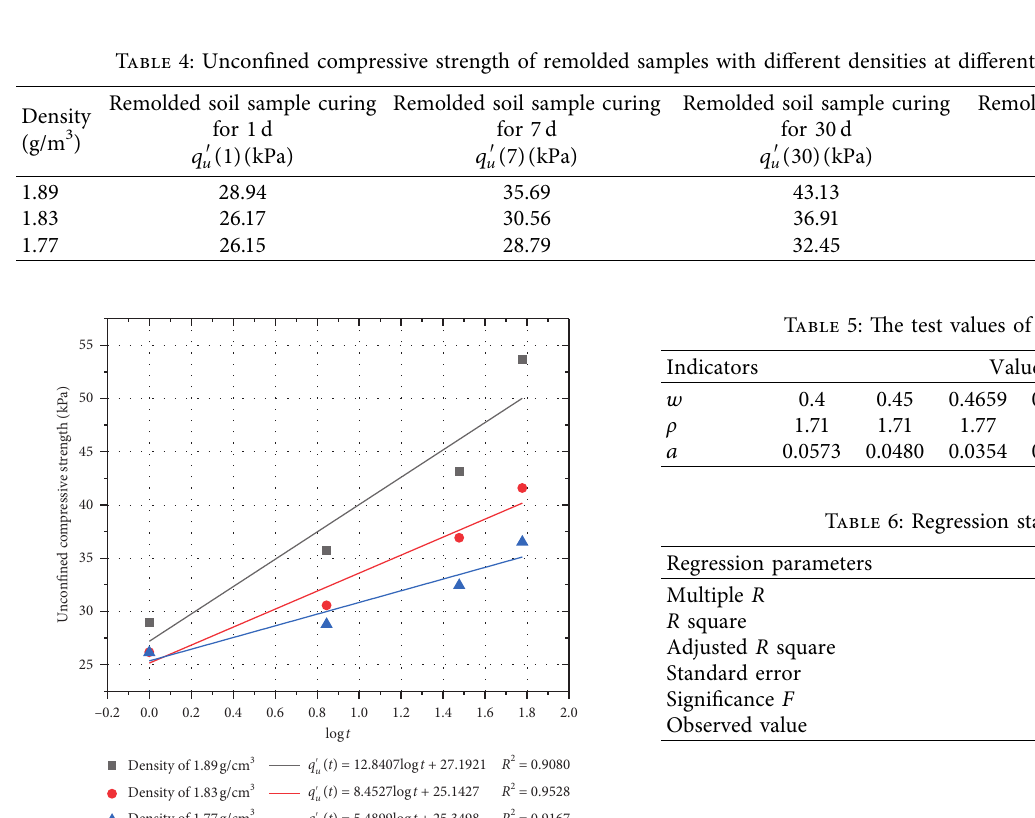
Table 7: Regression